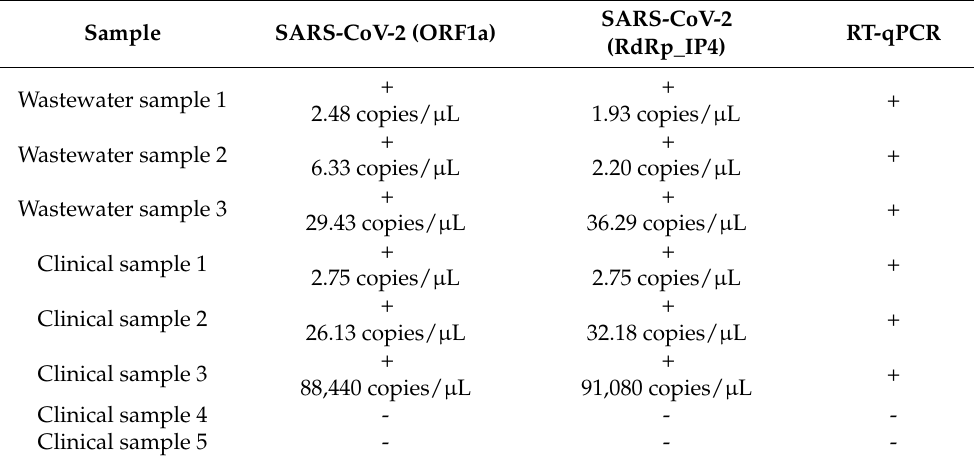
Table 5. SARS-CoV-2 investigation in clinical samples and wastewater